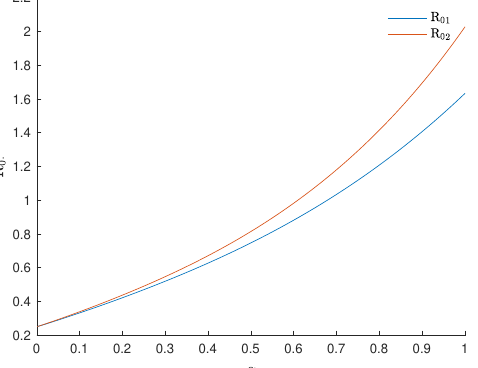
Figure 1. Impact of the variation of derivative order, α , in the basic reproduction numbers of both communities (3) and (4), respectively, R 01 and R 02